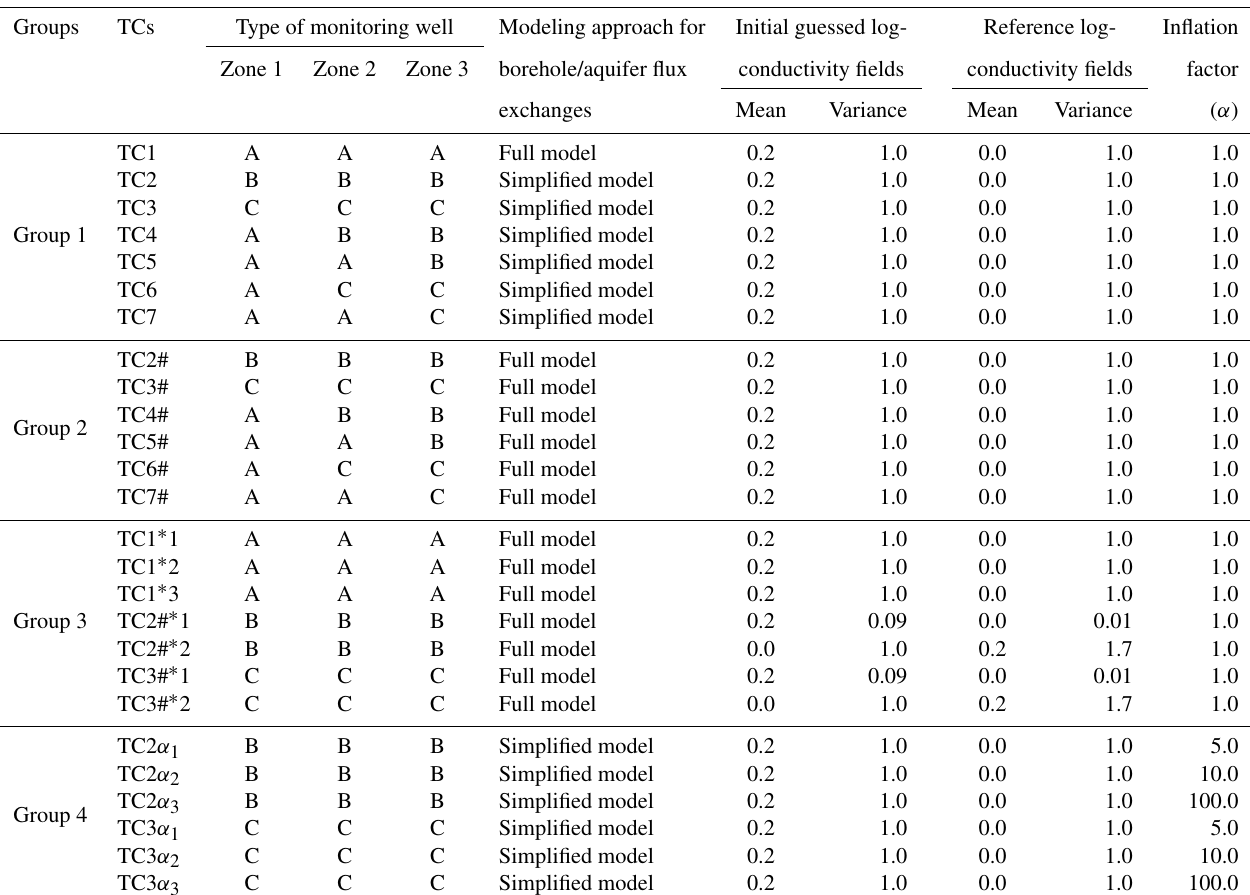
Figure 3. Reference log-conductivity ( Y ) field (a) and location of monitoring wells within the flow domain (b) . Table 1. Summary of the test cases